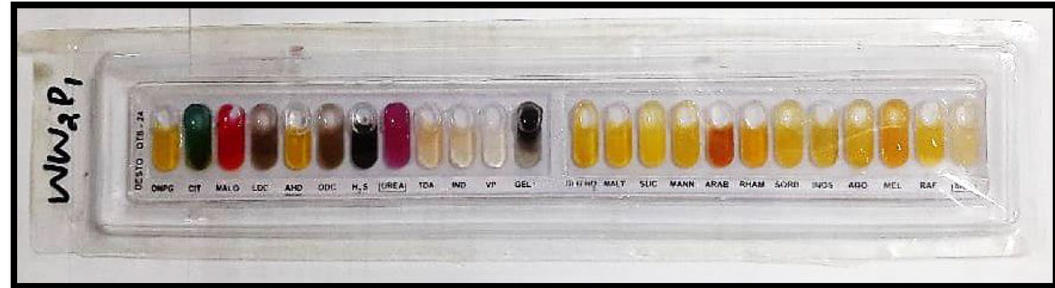
Fig. 2 Biochemical identification of bacterial strain WW